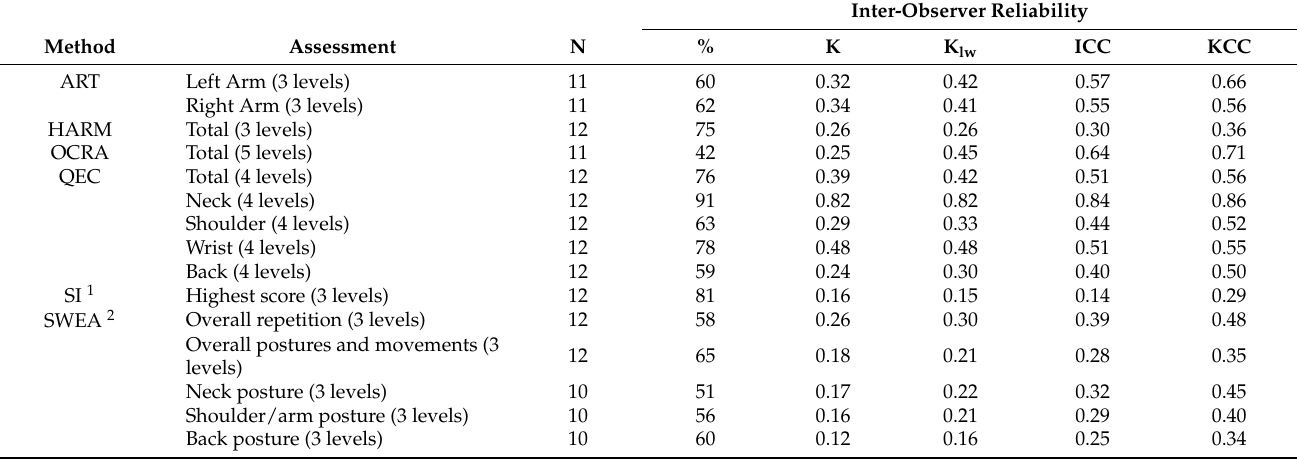
Table 5. Inter-observer reliability of risk levels, with standardized work task duration, using 3 h 45 min for all ten work tasks . The item ratings were first used to compute the risk scores for each method and were then transposed into risk levels according to the instructions for each of the methods. Number of ergonomists (n), proportional agreement (%), Cohen’s kappa (K), linearly weighted kappa averaged over pairs (K lw ), intraclass correlation (ICC) and Kendall’s coefficient of concordance (KCC) for the results of the ergonomists’ ratings of the ten different video-recorded work